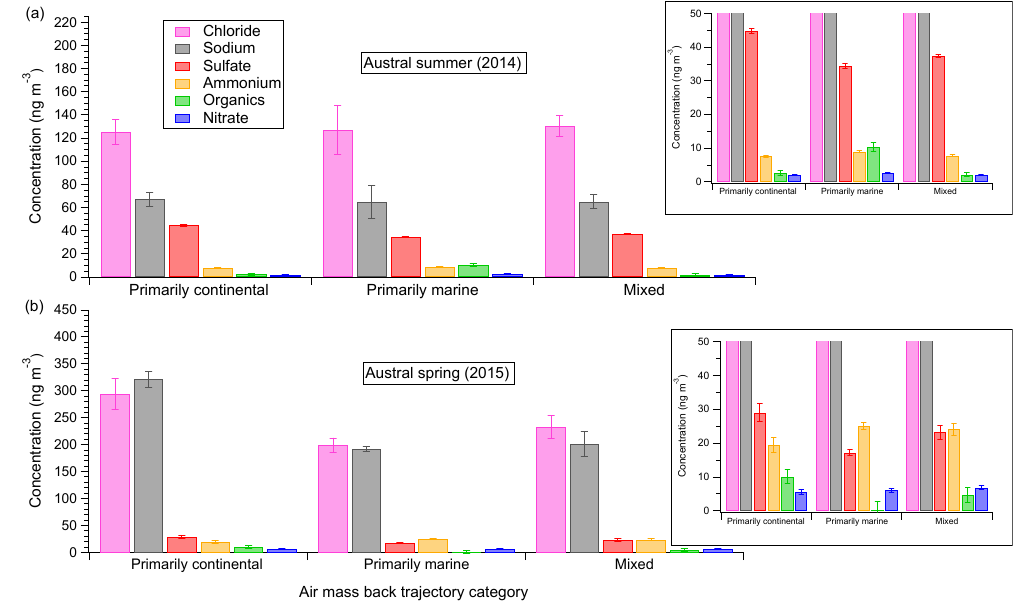
Figure 6. Aerosol-phase concentrations of AMS species as a function of air mass back-trajectory categories for the austral summer (a) and spring (b) measurement durations, including inset zooms for lower-concentration species. Error bars shown indicate standard error of the